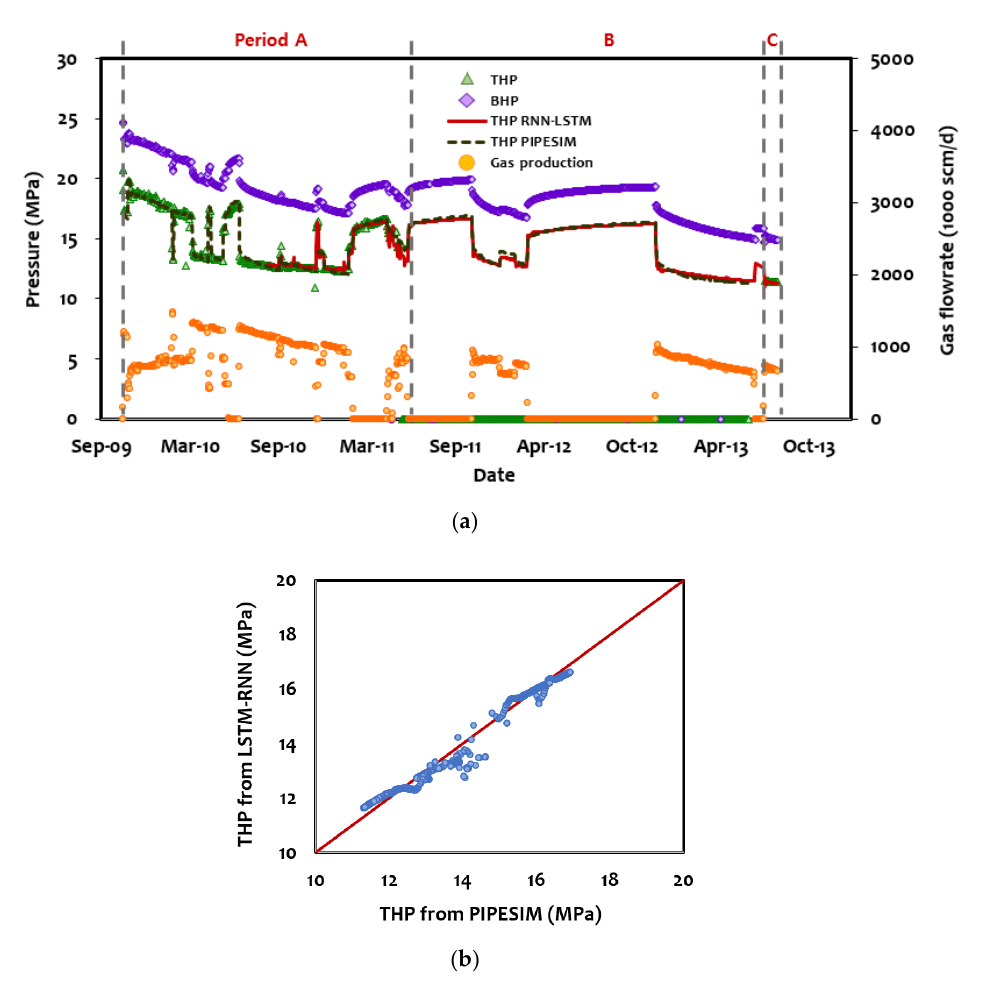
Figure 8. Comparison of THP predictions in Period B: ( a ) THP prediction profile, and ( b ) comparison between the results of the RNN-LSTM and PIPESIM models (modified from Ki et al. [25]).